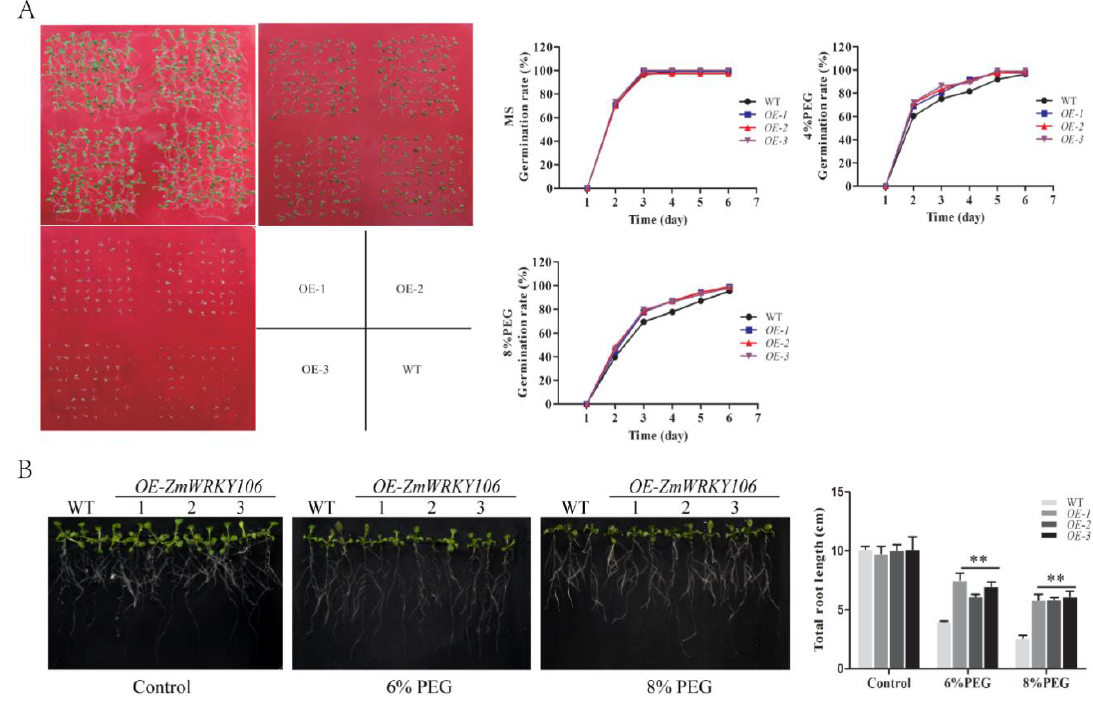
Figure 5. Phenotypes of ZmWRKY106 transgenic Arabidopsis under drought treatment. ( A ) Seed germinations of wild-type (WT) and ZmWRKY106 -overexpressing lines. ( B ) Root lengths of WT and ZmWRKY106 transgenic plants. Five-day-old seedlings were transferred to MS medium supplemented with or without PEG6000 for seven days, and then root lengths were measured. All the data represent the means ± SDs of three independent biological replicates and asterisks (**) represent the significant differences at p < 0.01 (Student’s t -test).